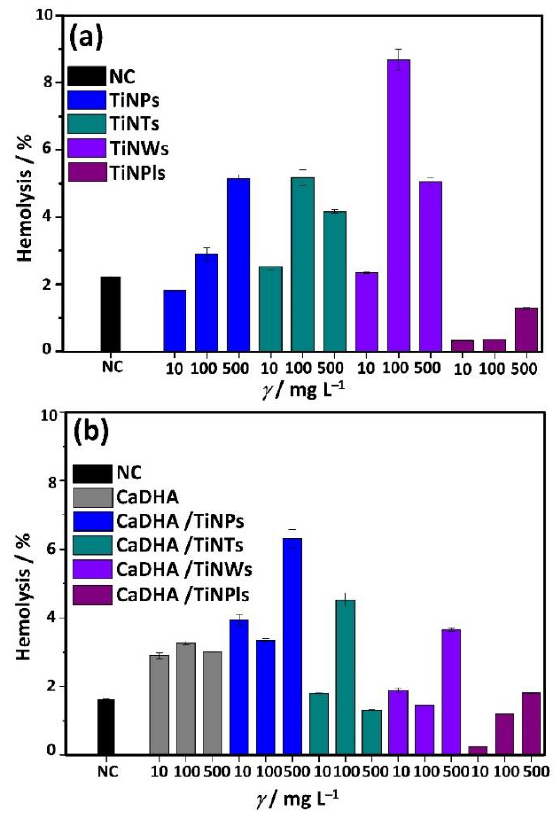
Figure 10. The results of the hemolysis assay on different concentrations (10, 100, and 500 mg L − 1 ) of ( a ) TiO 2 nanoparticles (TiNPs), titanate nanotubes (TiNTs), TiO 2 nanowires (TiNWs), and TiO 2 nanoplates (TiNPls), and ( b ) precipitates formed after 60 min of reaction time in the control sys- tem (calcium deficient hydroxyapatite, CaDHA) and the presence of 100 mg L − 1 TiO 2 nanoparti- cles (CaDHA/TiNPs), nanotubes (CaDHA/TiNTs), nanowires (CaDHA/TiNWs), and nanoplates (CaDHA/TiNPls) suspended in phosphate buffered saline